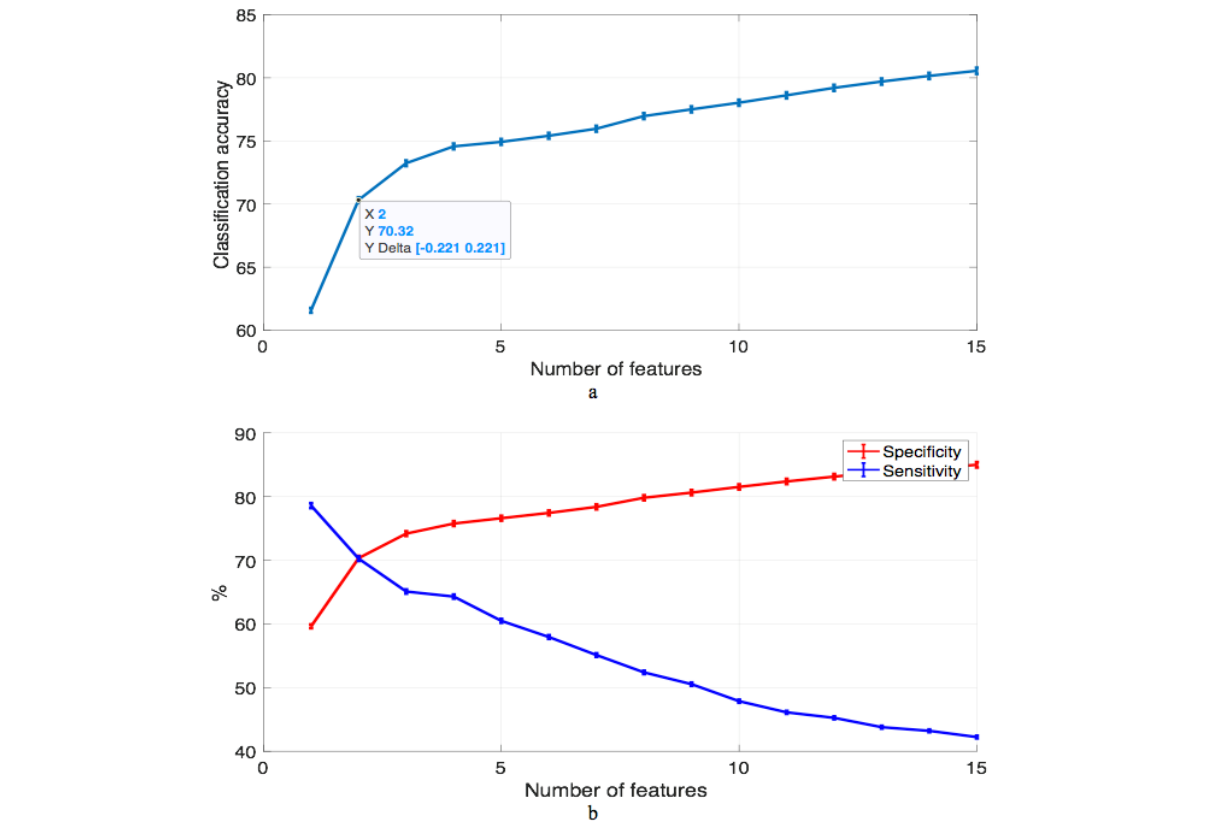
Figure 3. Performance of support vector machine classifier for subdataset: (a) classification accuracy ± standard error and (b) sensitivity and specificity ± standard